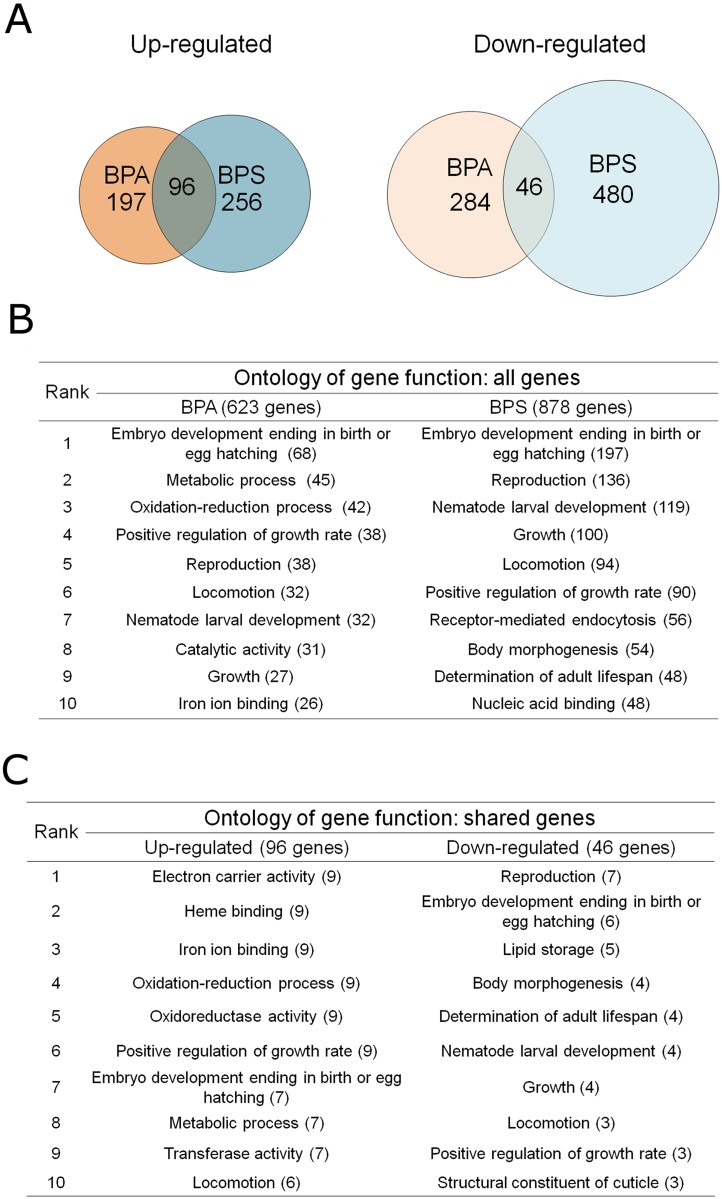
BPA and BPS show distinct alterations of gene expression at whole transcriptome level.(A) Venn diagrams representing the number of genes with a significant (P≤0.05) up- and down-regulation by more than 1.2-fold following exposure to BPA or BPS exposure at 500 μM as assessed by the RNA sequencing analysis of 5 replicates for each treatment group. (B) Functional ontology analysis of all genes identified through the RNA-seq analysis as altered by either BPA or BPS. (C) Functional ontology analysis of shared genes either up- or down- regulated by both BPA and BPS.